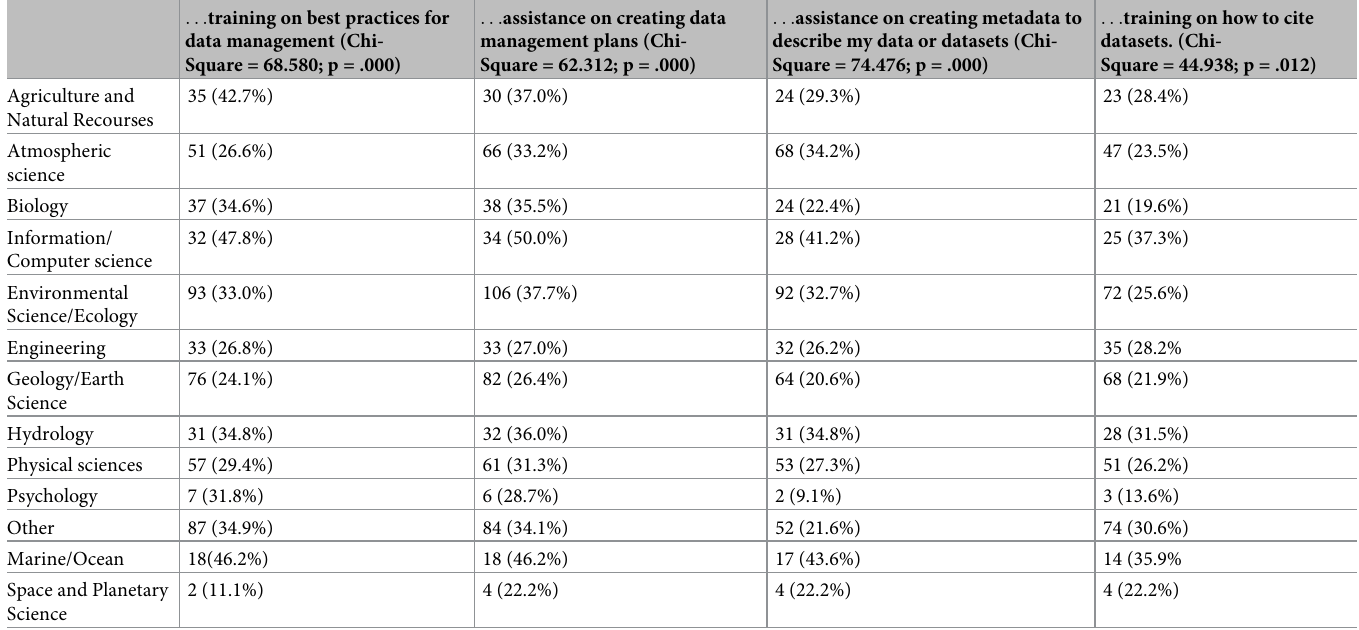
Table 5. Crosstab between “Primary Subject Discipline” and “My organization or project provides ... ”.